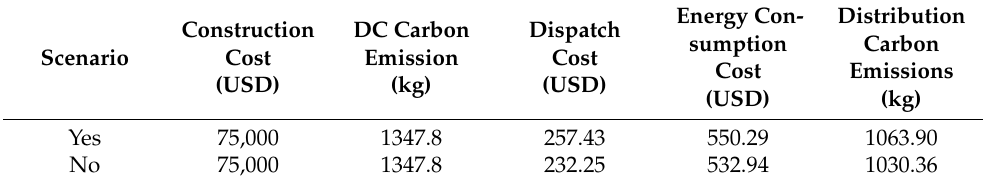
Table 9. Comparison of carbon emissions with and without cargo splitting considering traffic